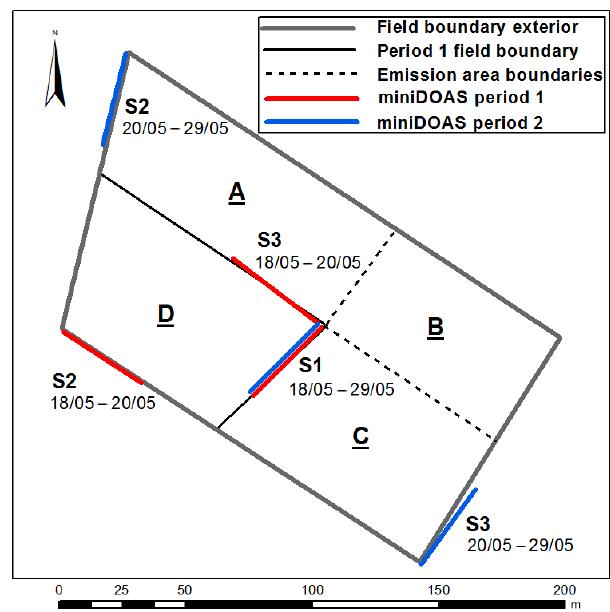
Figure 1. Map of the grazed field showing positions of the three miniDOAS open-path measurement systems. During Period 1 (18– 20 May) 25 cattle were fenced within the SW field section (area D). During Period 2 (20–29 May) the internal field boundaries were re- moved so that the cattle could graze the whole field. Later, for the attribution of emissions across the field, emission area quadrants were allocated, marked A–D. There were no physical barriers be- tween the emission areas during Period